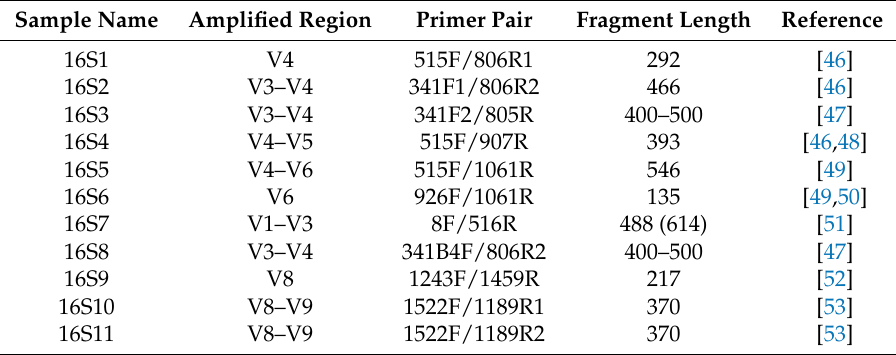
Table 1. Overview of samples generated for MiSeq sequencing, their corresponding amplified regions, primer pairs employed for amplification, fragment lengths, and